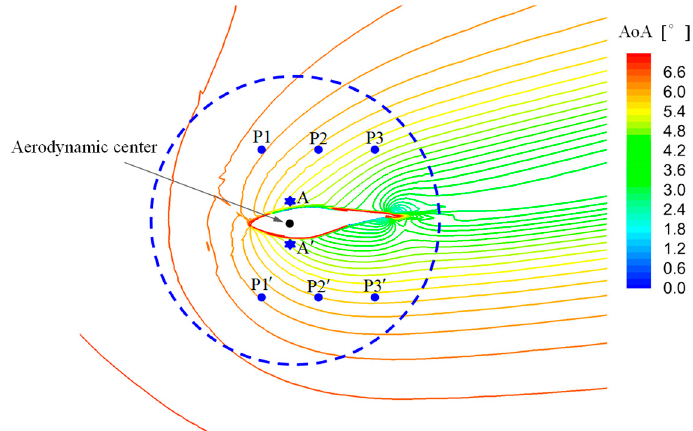
the blade axis as well as the effective AoA are estimated (